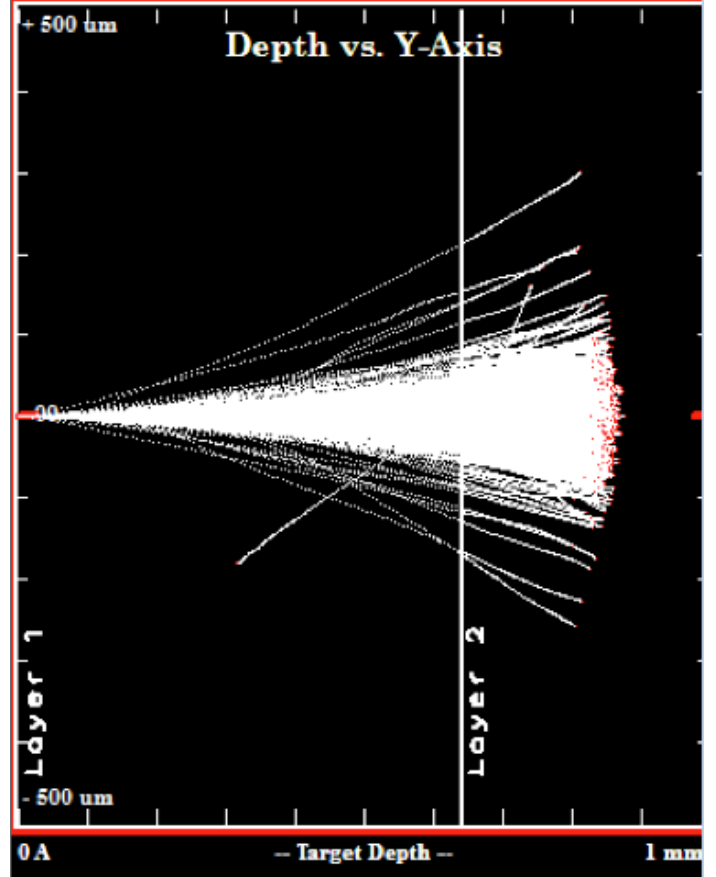
Figure S2. Results of a Monte Carlo simulation [28] of 14.7 MeV protons ( N = 1,000), travelling from left to right, as they pass through a 0.64 mm thick Y foil (Layer 1), and stopping within 0.3 mm after entering the Nb base of the target holder (Layer 2). The entire thickness of the base (4.83 mm) is not shown. This diagram assumes that the Y foil is perfectly in contact with the Nb